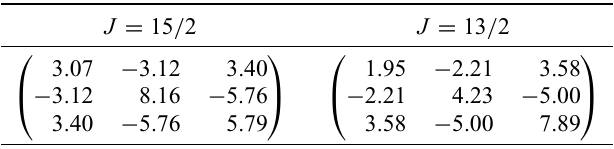
TABLE II. The g tensors of the ground state doublets in the J = 15 / 2 and J = 13 / 2 manifolds of Er 3 + :Y 2 SiO 5 [38]. We show here only site 1 in orientation I; orientation II is related by a symmetry operation.